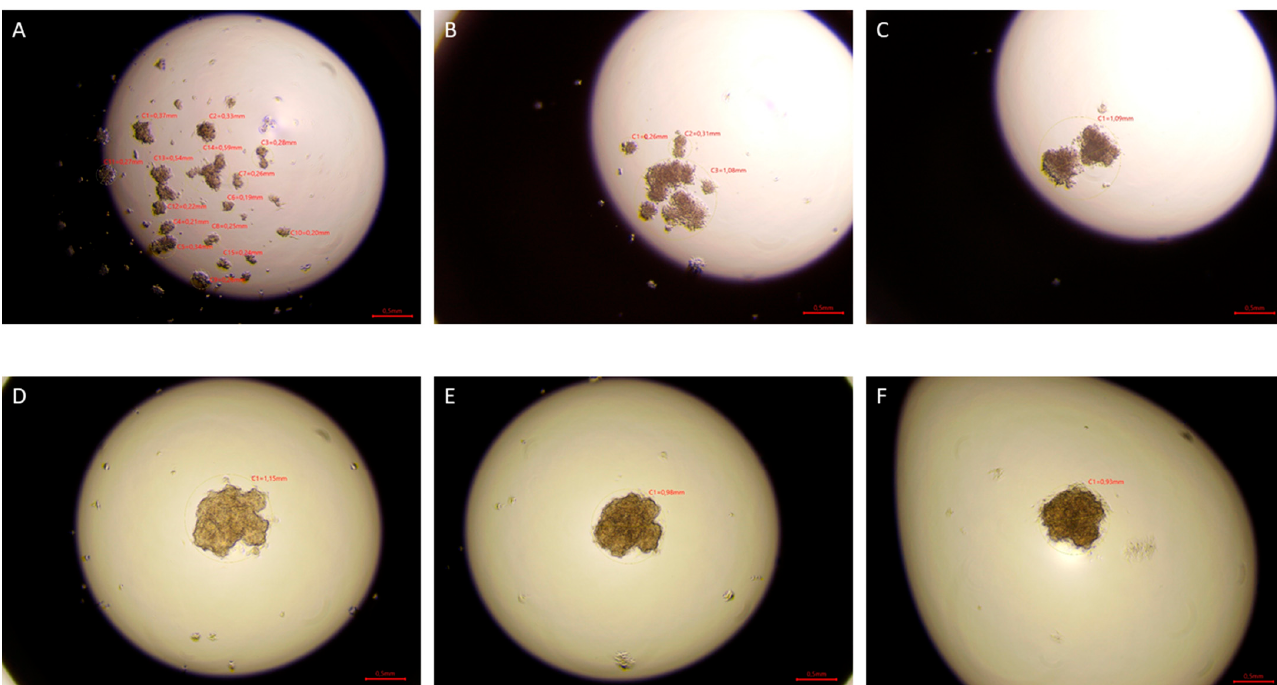
Figure 9. 769-P cells in hanging drop culture. ( A – C ) show 769-P cells from the control group 24, 48, and 72 h from the start of the culture, respectively. ( D – F ) show 769-P cells exposed to 4.5 mT, 50 Hz EMF 24, 48, and 72 h from cultivation, respectively. Pictures taken with the Delta-Optical IB-100 microscope, 4× magnification .